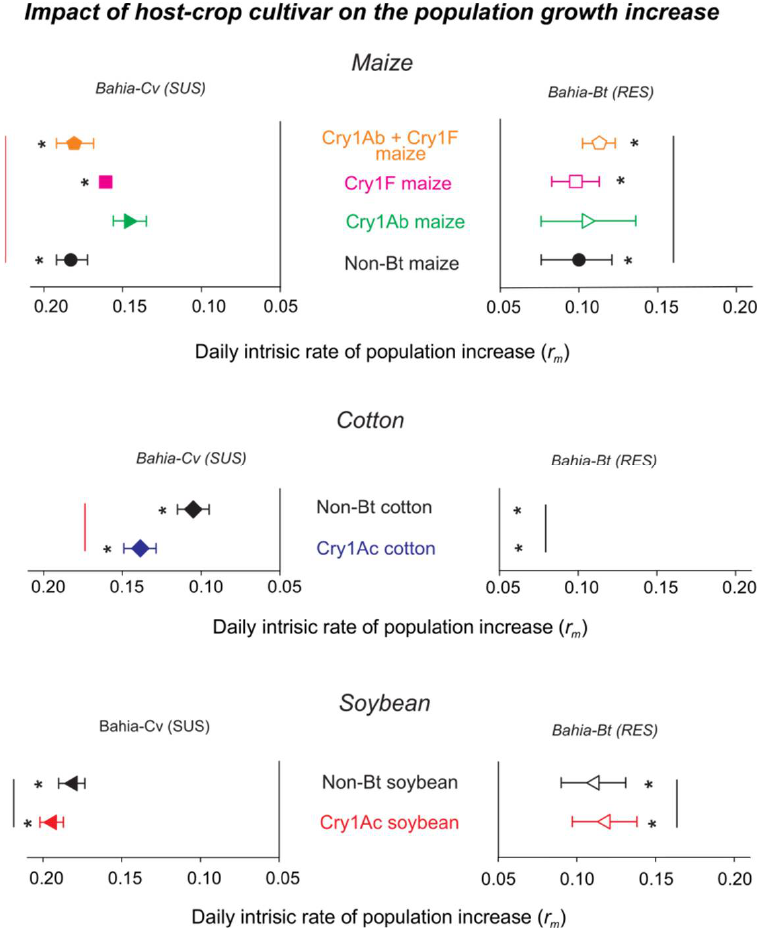
Figure 3. Population fitness costs of fall armyworm ( Spodoptera frugiperda ) resistance to dual-gene Bt maize (Cry1A.105+Cry2Ab2). Shown are intrinsic rates of population increase for Bt-resistant and -susceptible fall armyworms reared on the foliage of eight host-plant cultivars (n = 12–17 families per insect population per host-plant cultivar). Data are means and standard errors. * Reduced population fitness ( p < 0.05), one-tailed t -test using jackknife-estimated variances. Values under the same vertical line are not significantly different ( p < 0.05) using Bonferonni correction. Table 2. Fitness costs of fall armyworm resistance to dual-gene Bt maize (Cry1A.105+Cry2Ab2). Shown are population growth statistics for Bt-resistant and -susceptible fall armyworms reared on the foliage of eight host-plant cultivars ( n = 12–17 families per insect population per host-plant cultivar).